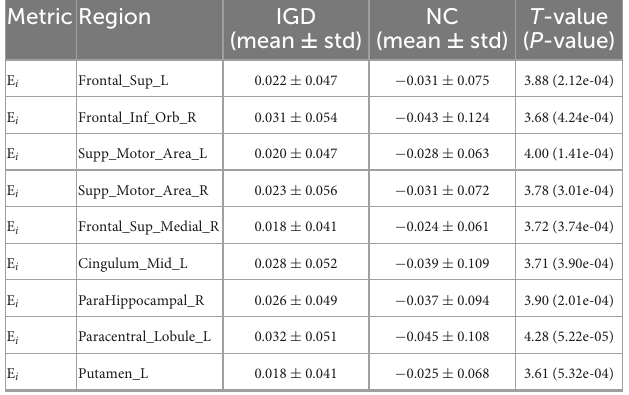
TABLE 5 Differences in nodal efficiency between young people with IGD and HC. Metric